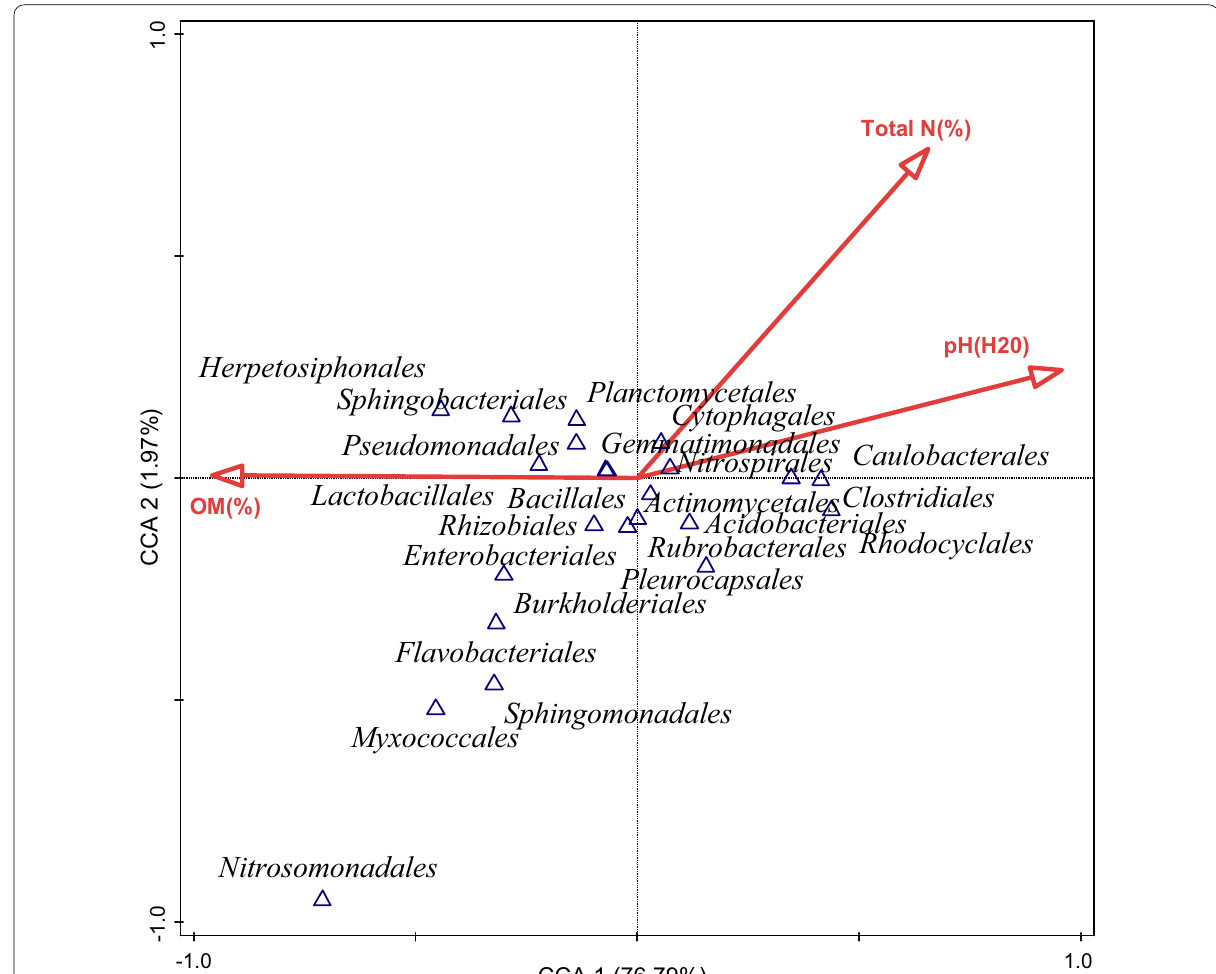
Fig. 5 The influence of pH, total N and OM on the bacterial components (at the order level) of sunflower rhizosphere and bulk soils obtained from Ditsobottla and Kraaipan farms using Canonical correspondence analysis. N nitrate; % percentage; OM organic matter; R1 Ditsobottla rhizosphere soil; B1 Ditsobottla bulk soil; R2 Kraaipan rhizosphere soil; B2 Kraaipan bulk